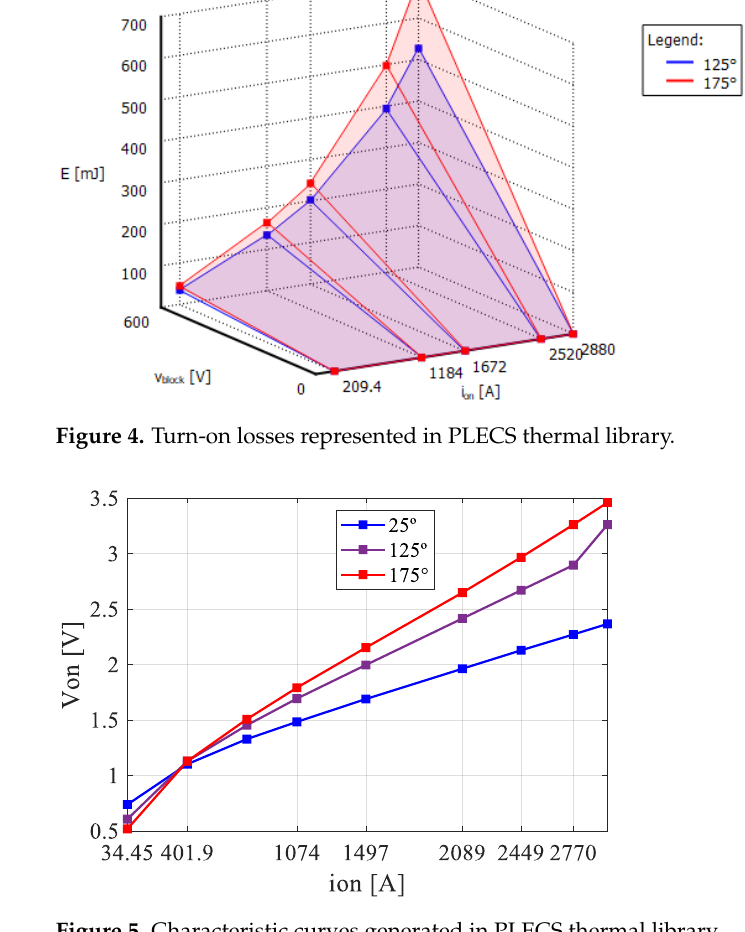
Figure 5. Characteristic curves generated in PLECS thermal library.